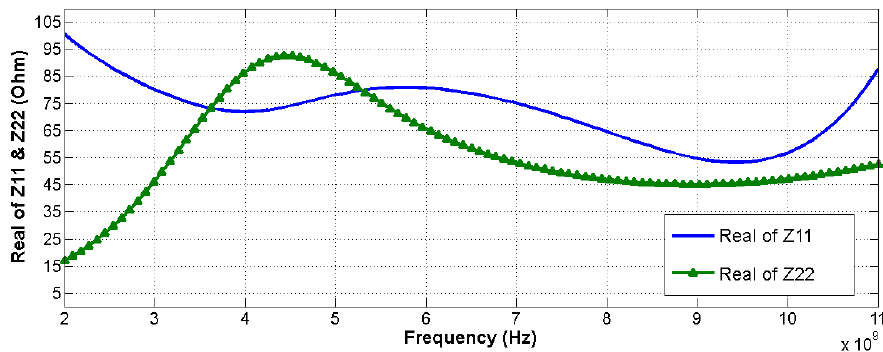
Figure 10. Impedance curves of input and output matching network ( Z 11 and Z 22).